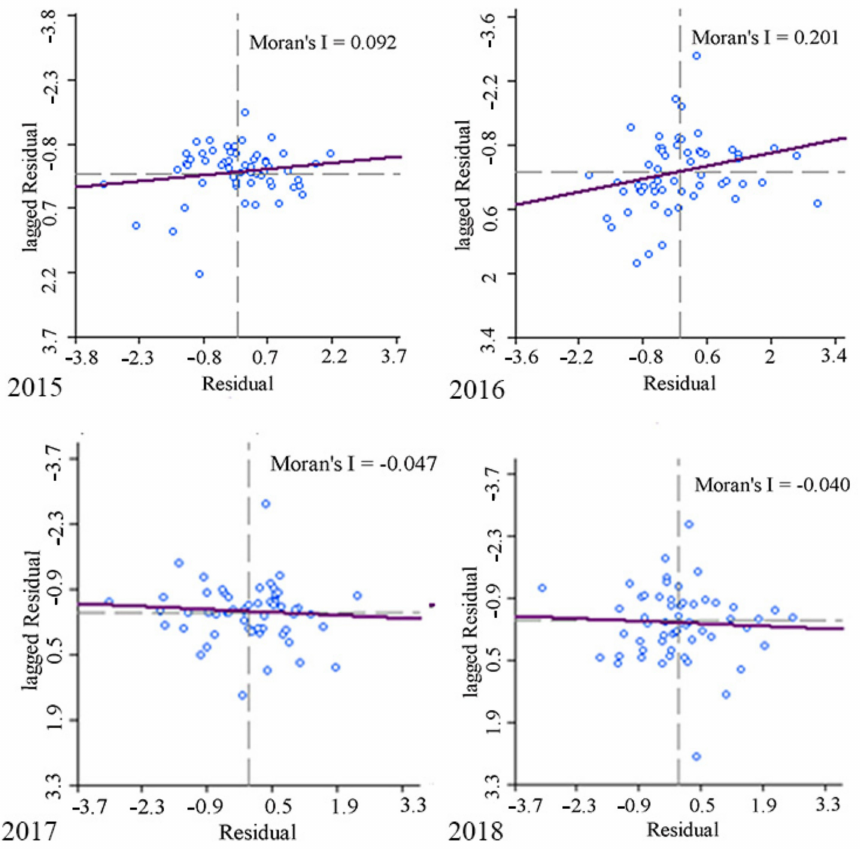
Figure 5. Moran scatter diagram of OLS regression residual terms of the village-level factors from 2015 to